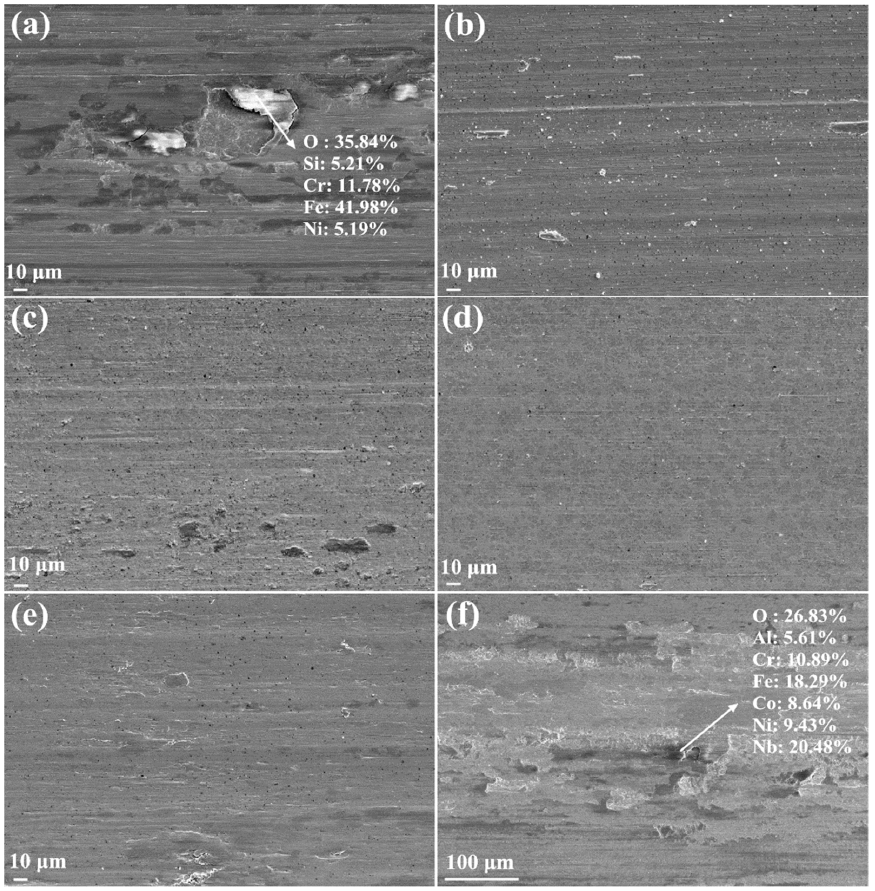
Figure 8. SEM images of wear surfaces: ( a ) the substrate and ( b ) Nb0, ( c ) Nb0.25, ( d ) Nb0.5, ( e ) Nb0.75, ( f ) Nb1.0.